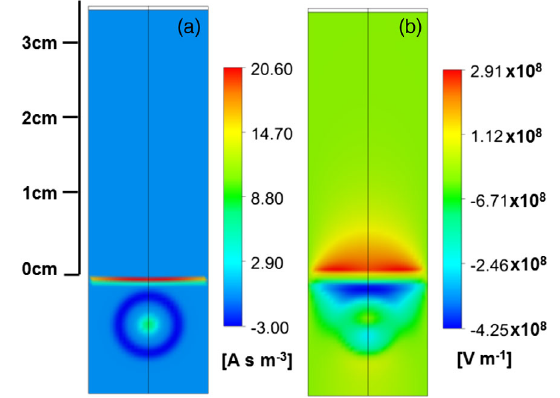
FIG. 16. Simulated deposited charge density on the solid powder phase (a) and resultant vertical electric field (b) immedi- ately following a beam pulse of 3 × 10 12